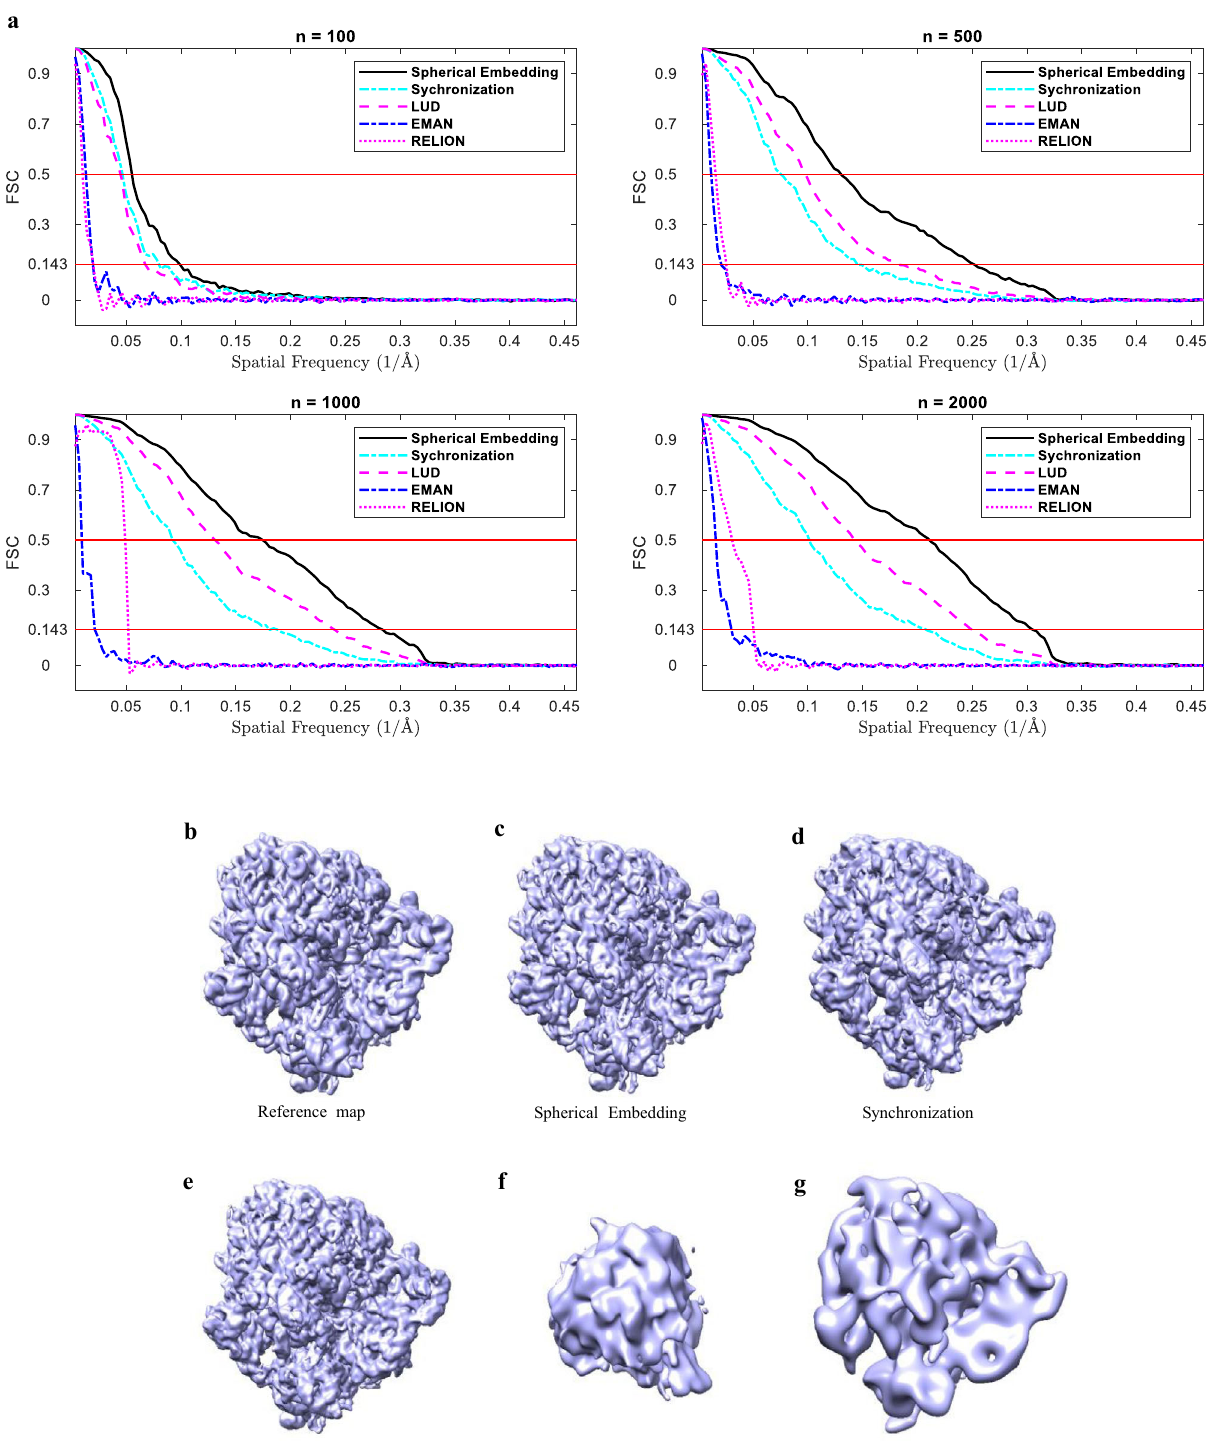
Fig. 4 Comparison of the FSC curves produced from different number of projection images ( n = 100, n = 500, n = 1000, and n = 2000), and the comparison of the reconstructions by different methods for the simulated data ( n = 1000, SNR = 0.2). a The FSC curves produced from different number of projection images ( n = 100, n = 500, n = 1000, and n = 2000) by the proposed method (Spherical Embedding), Synchronization, LUD, EMAN 2.1, and RELION-2. b The reference density map (EMD-3508). Others are the reconstructed maps by: c the proposed method (Spherical